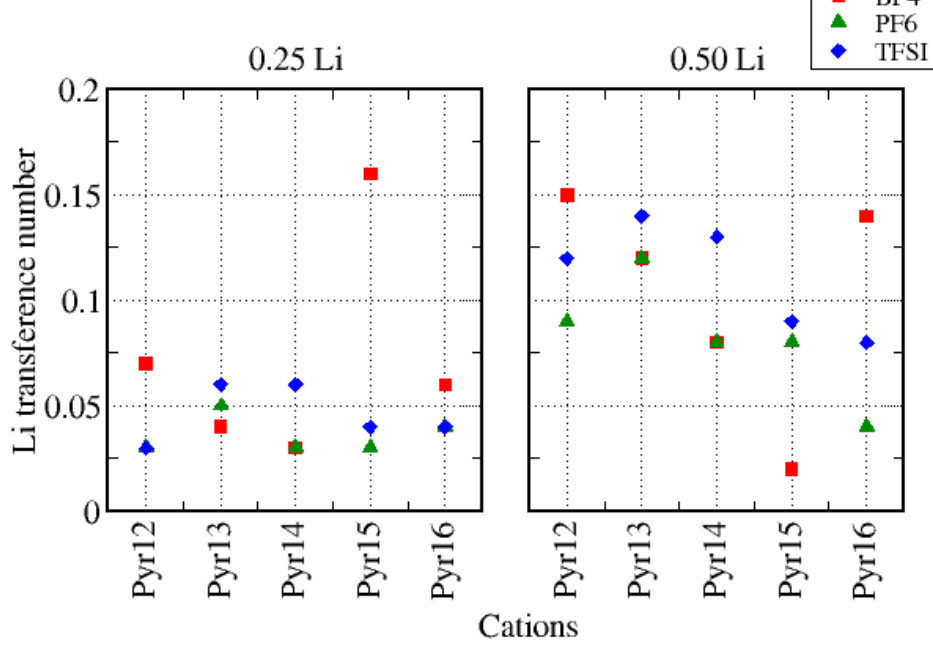
Figure 14. Transference number ( t Li ) as a function of Pyr1X, for the systems with different amounts of